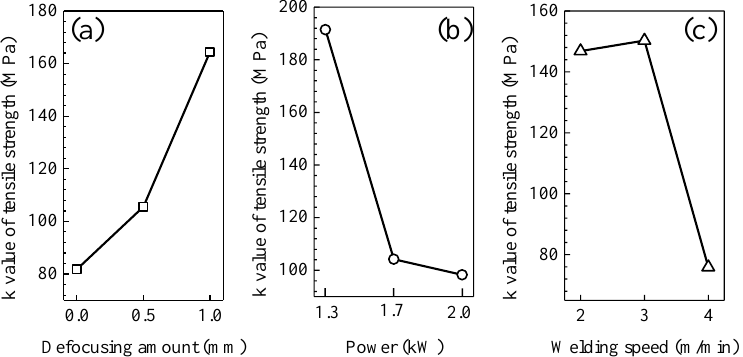
Figure 7. The stress – displacement curves of the Mo – Re welded joints with a thickness of 0.5 mm. Table 6. Analysis results of the maximum tensile strengths of the Mo – Re welded joints with a thick- ness of 0.5 mm, obtained through a three-factor and three-level orthogonal test.